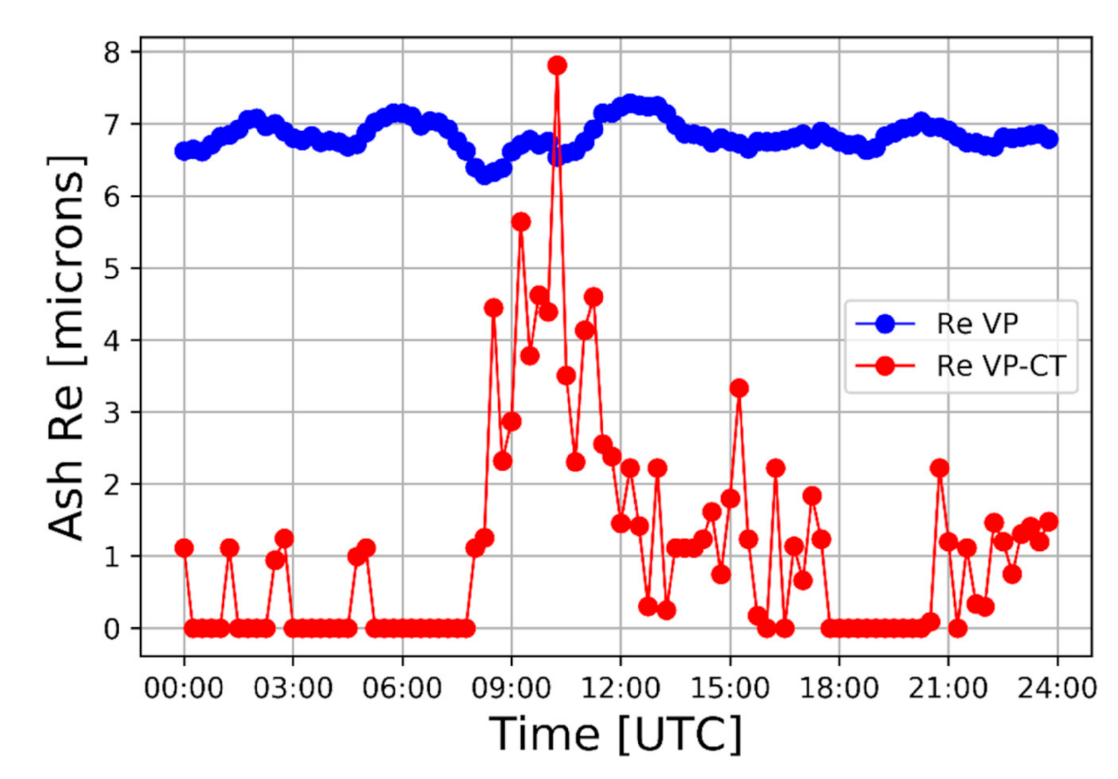
Figure 7. E ff ective radius (Re) obtained from SEVIRI measurements every 15 min. Blue line: mean Re computed considering the overall volcanic plume (Re VP). Redline: Re of a single pixel placed